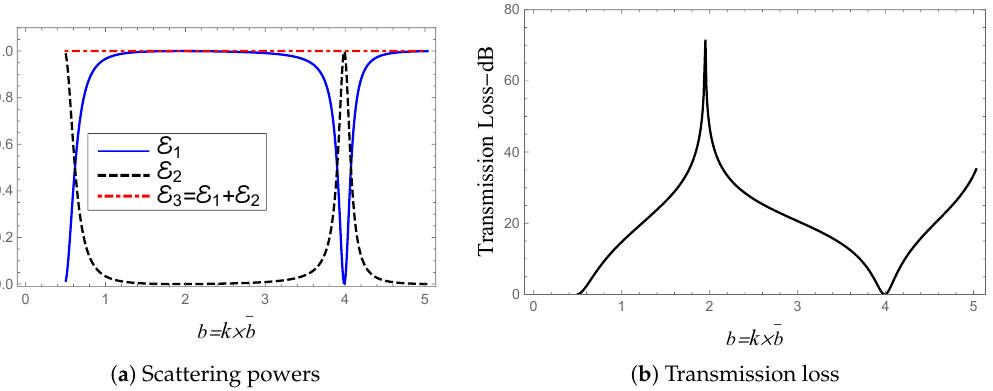
Figure 11. Chamber problem: Scattering powers and transmission loss against non-dimensional radius b with ¯ a = 0.05 m, f = 550 m and ¯ L = 0.05 m.